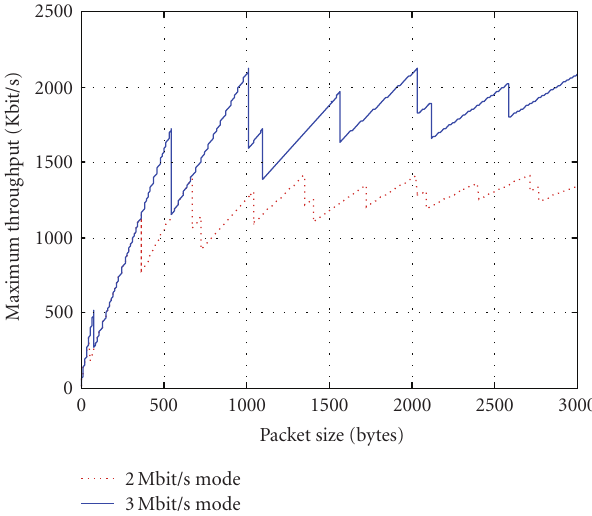
Figure 1: Throughput quantization e ff ects for Bluetooth EDR